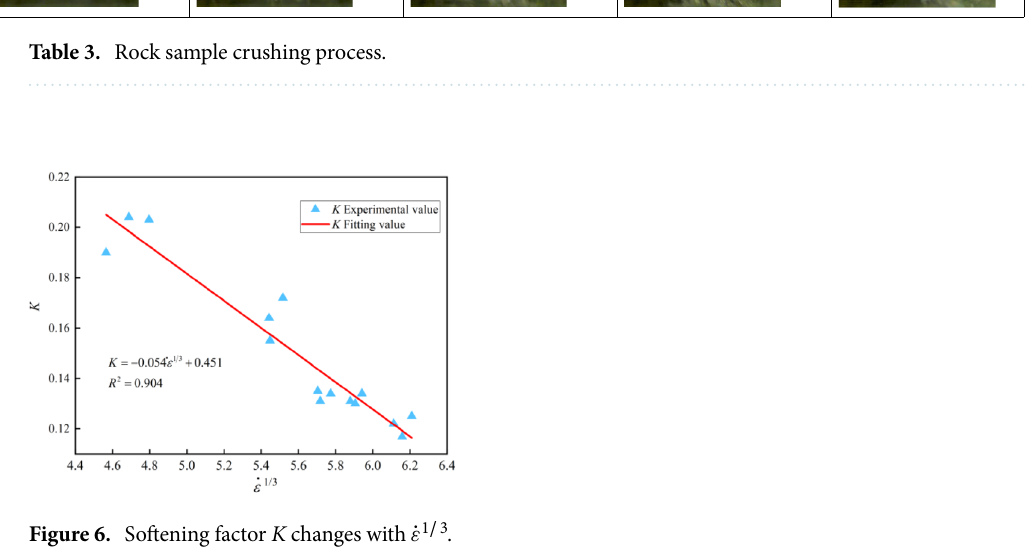
Figure 6. Softening factor K changes with ˙ ε